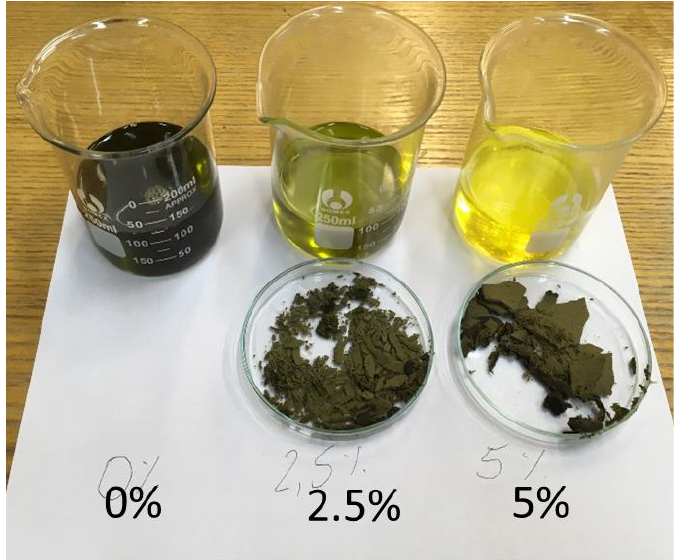
Figure 1. Change in the color of hemp oil as a result of the bleaching process using 2.5% and 5.0% bleaching earth m/m to oil.